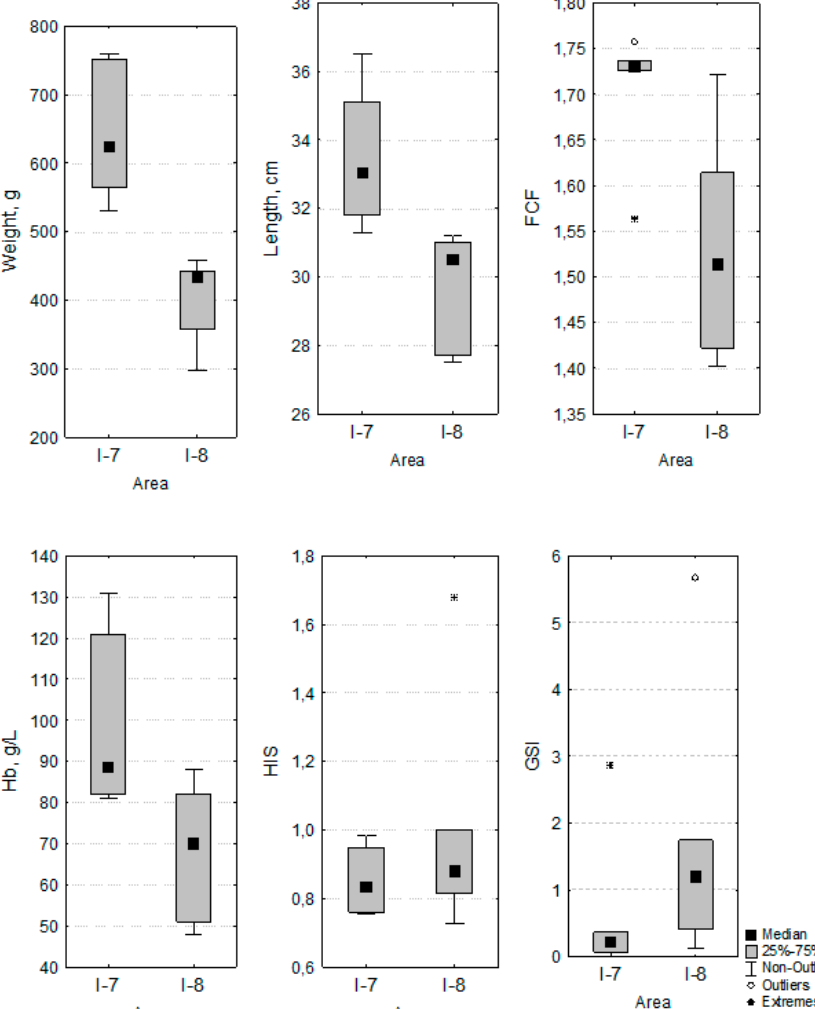
Figure 1. Weight, length, Fulton’s condition factor (FCF), blood hemoglobin concentration (Hb), hepatosomatic index (HIS), and gonadosomatic index (GSI) of the whitefish from the thermal pollution area (I-8) and the natural habitat area (I-8).